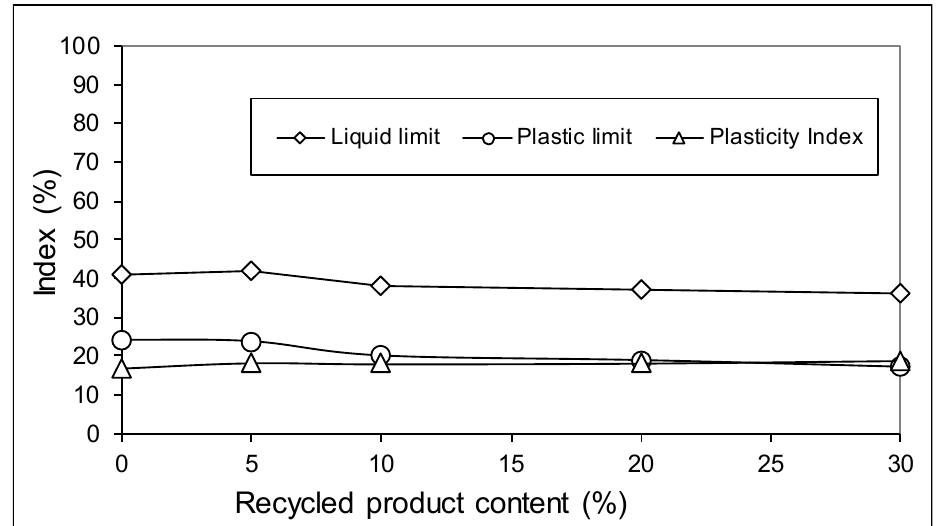
Figure 6. Variation of plasticity parameters.